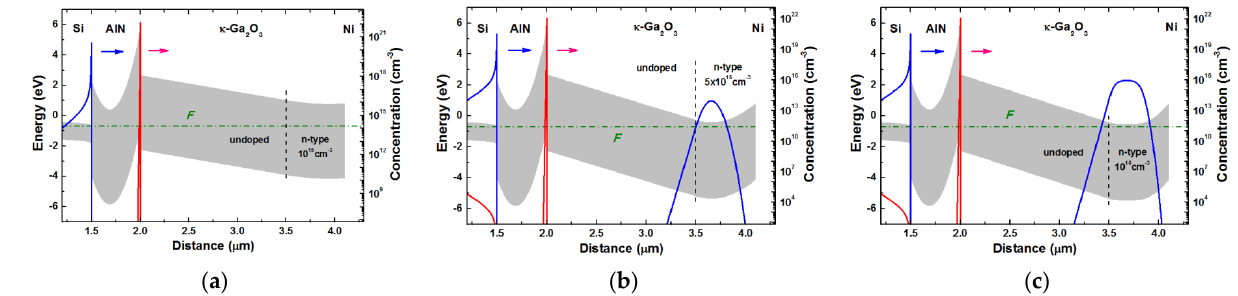
Figure 7. Calculated band diagrams and profiles of holes (red lines) and electrons (blue lines) in the κ‐ Ga 2 O 3 /AlN(0001)/Si(111) heterojunctions with three different donor concentrations ( a ) 1 × 10 15 cm − 3 , ( b ) 5 × 10 15 cm − 3 , ( c ) 1 × 10 16 cm − 3 ; the arrows show the spontaneous polarization vector direction. Electron distribution is shown by red lines and that of holes by blue